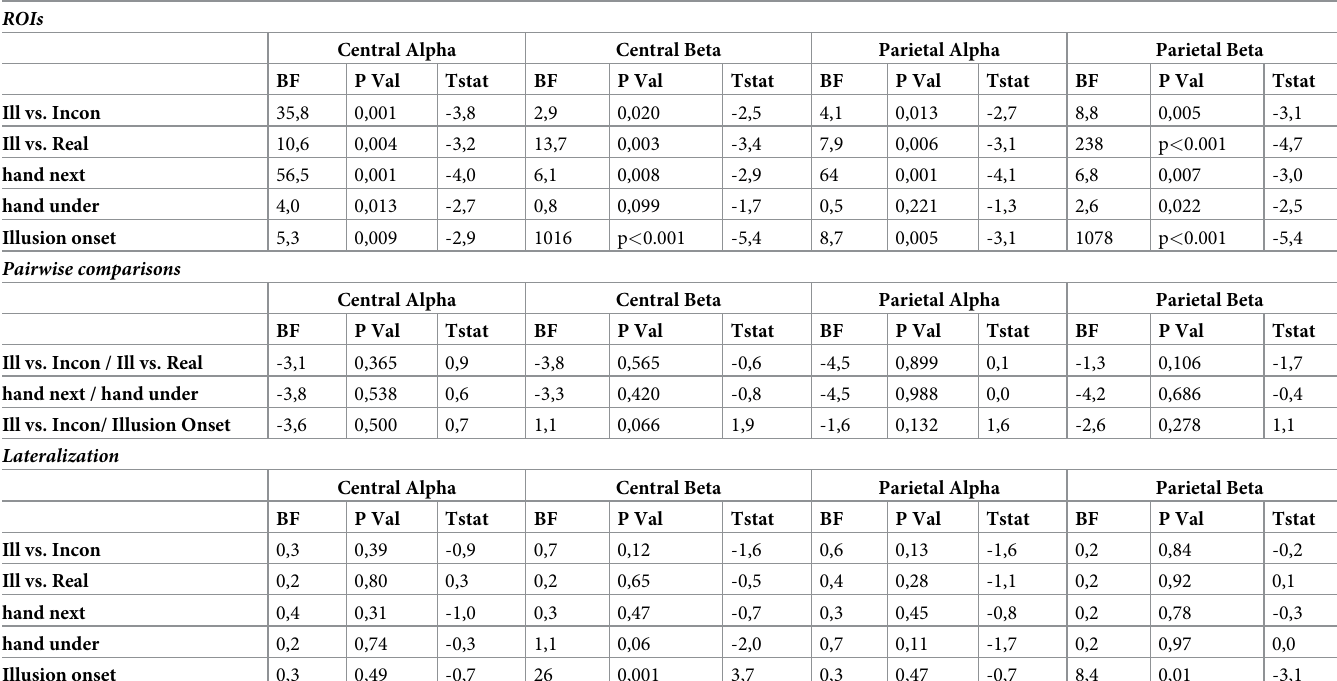
Table 1. ROI-based results for central and parietal alpha and beta power. ROIs